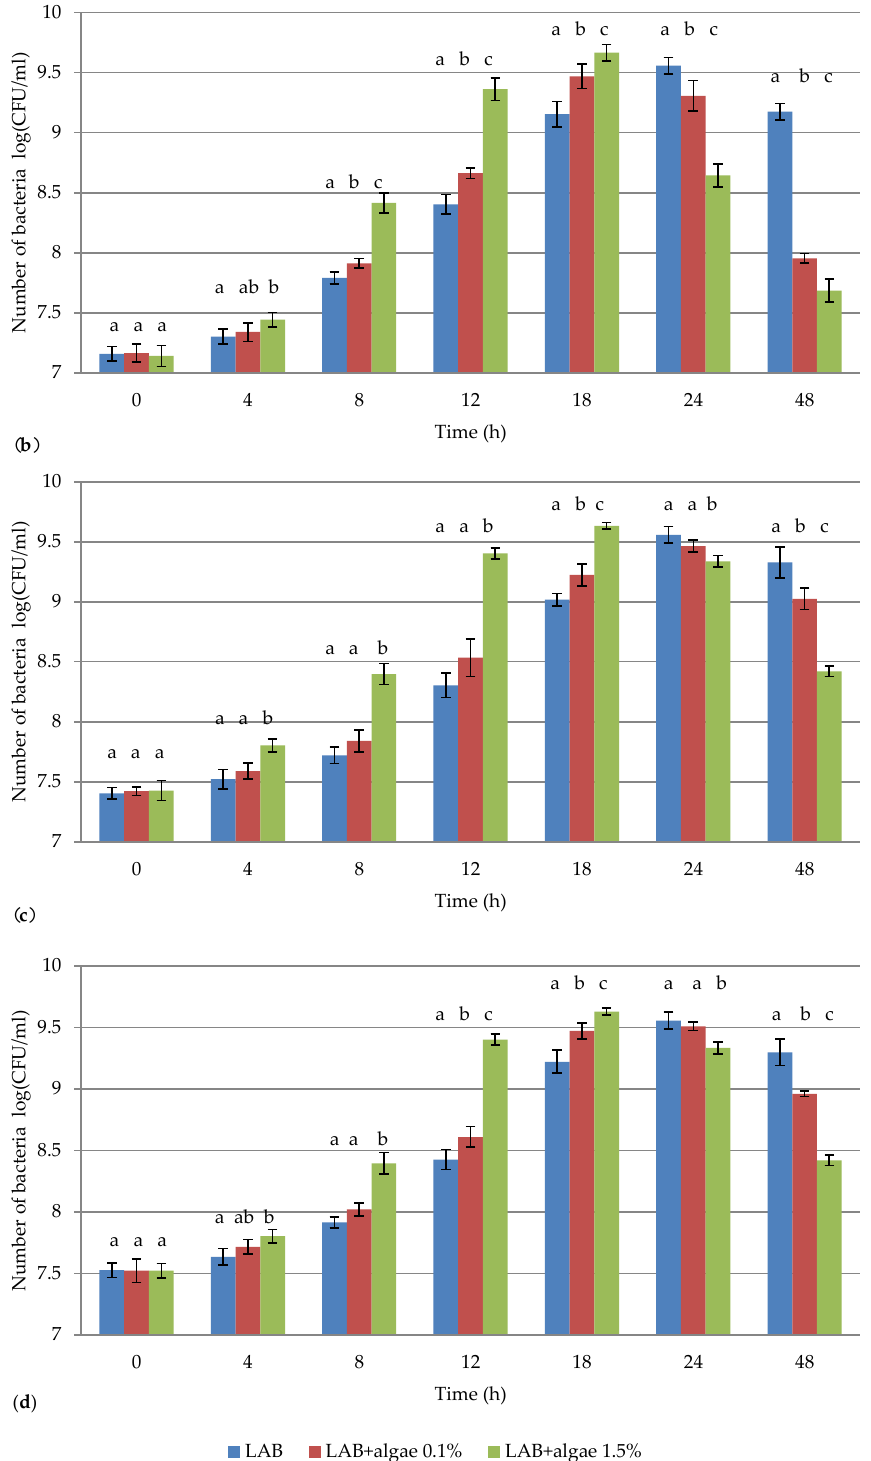
Figure 1. The survival of Lactobacillus brevis ( a ) ŁOCK 0944 ( b ) ŁOCK 0980 ( c ) ŁOCK 0992, and ( d ) MG451814 in the presence of the algae Chlorella vulgaris , at concentrations of 0.1% ( w / v ) and 1.5% ( w / v ). Explanatory notes: the figure shows mean values (bars) and standard deviations (line segments); LAB—lactic acid bacteria; a, b, c—the statistically significant di ff erences between samples of the same strains within one time interval; p < 0.05; n =